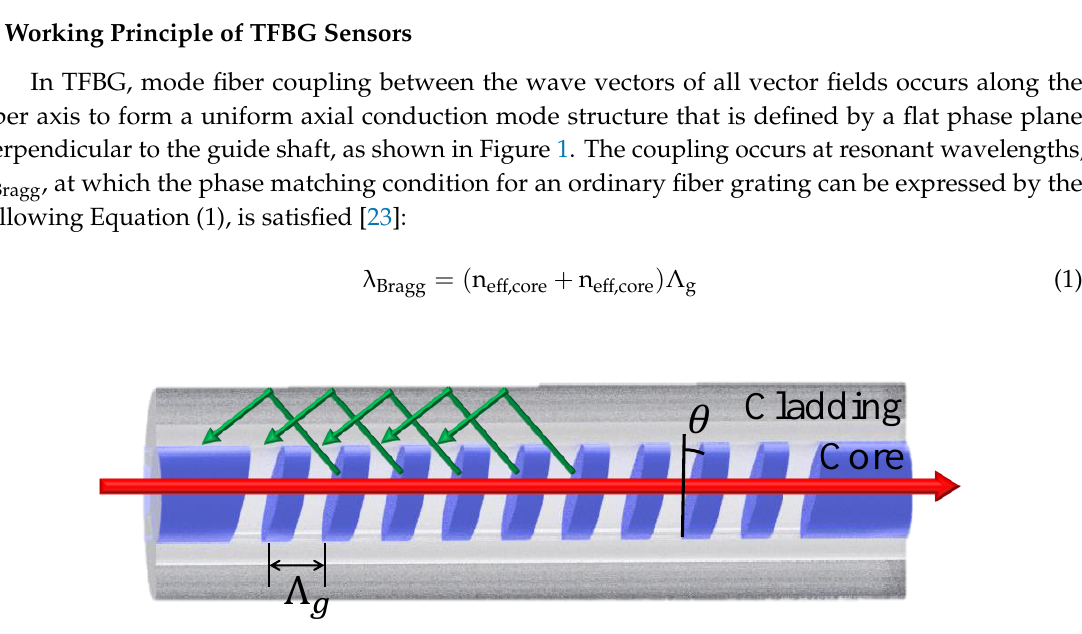
Figure 1. A schematic of TFBG with a tilt angle θ inscribed in the core of photosensitive fiber.